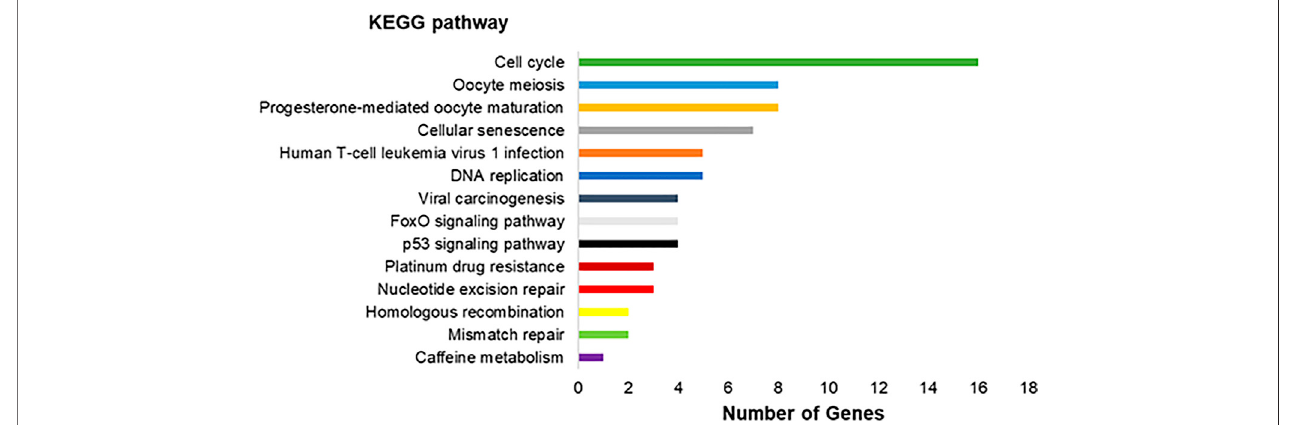
FIGURE 4 | Molecular interaction, networks, and respective number of differentially expressed genes found in the transcriptomic analysis in the exposed human salivary gland cells line to 2.5 µM of MeHg vs. nonexposed cells (MeHg vs. Control) represented by KEGG pathways.